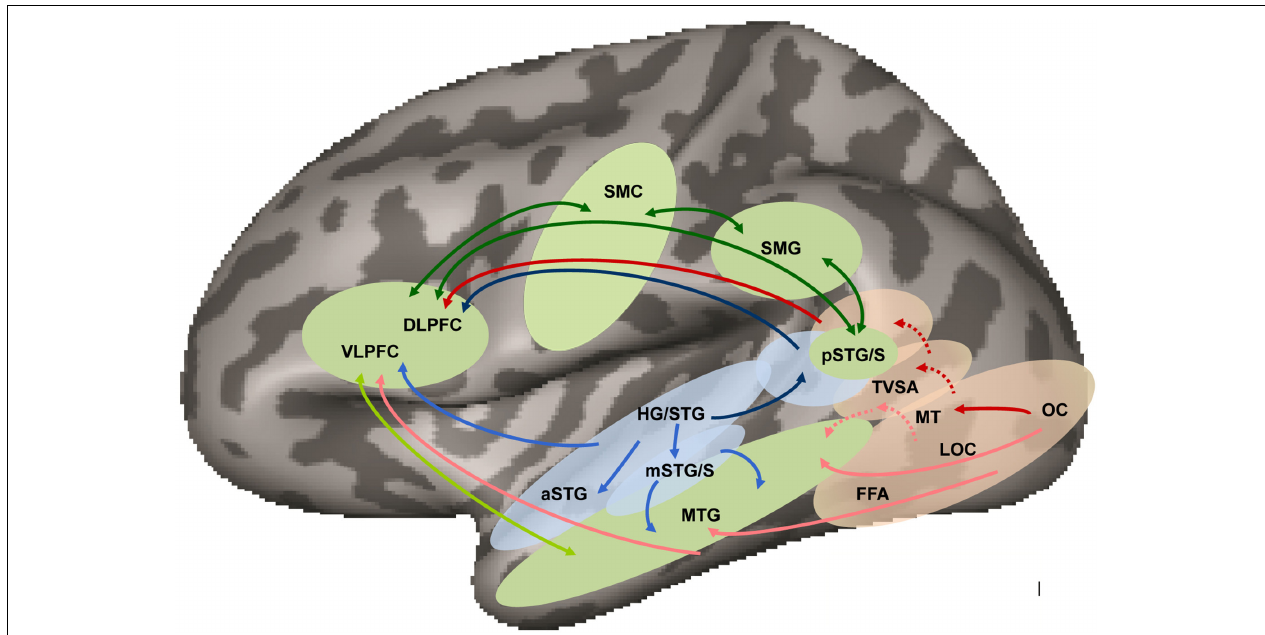
FIGURE 1 | Neuroanatomical working model of audiovisual speech perception in the left hemisphere based on models of dual visual (Wilson et al., 1993; Haxby et al., 1994; Ungerleider et al., 1998; Weiner and Grill-Spector, 2013) and auditory (Romanski et al., 1999; Hickok and Poeppel, 2007; Saur et al., 2008; Rauschecker and Scott, 2009; Liebenthal et al., 2010) pathways and audiovisual integration (Beauchamp et al., 2004) in humans. Audiovisual speech is processed in auditory (blue) and visual (pink) areas projecting to amodal (green) middle temporal cortex via auditory (light blue arrows) and visual (light red arrows) ventral pathways terminating in VLPFC, and to multimodal posterior temporal cortex via auditory (dark blue) and visual (dark red) dorsal pathways terminating in DLPFC. Specialization for phoneme processing is suggested to exist in both auditory and visual pathways, at